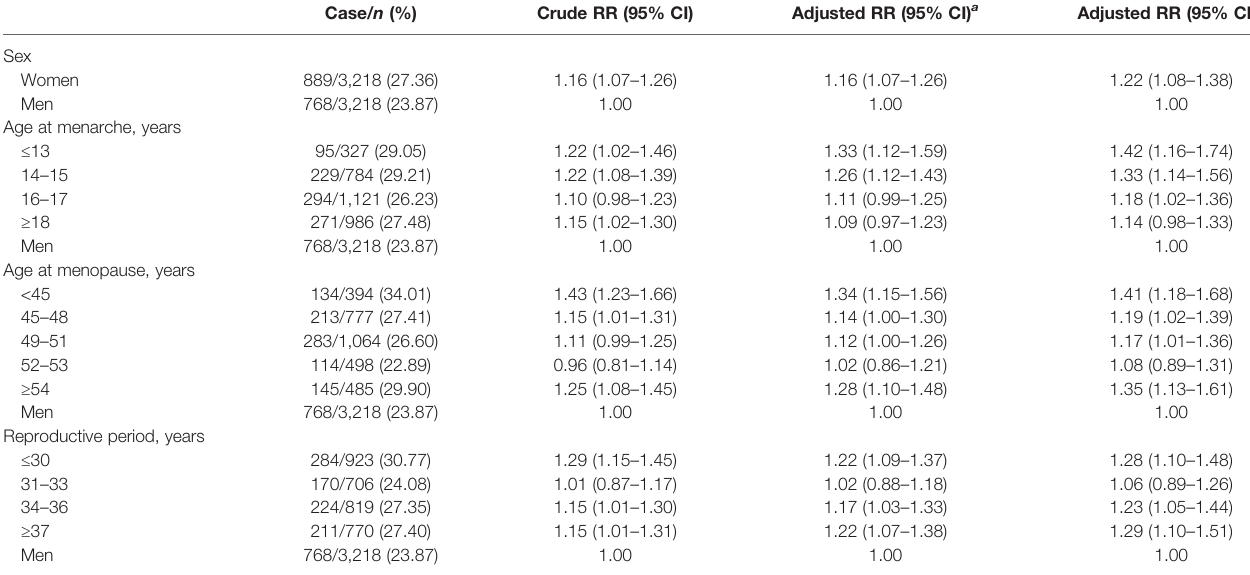
TABLE 2 | Association between sex, age at menarche, age at menopause, reproductive period, and objective memory impairment ( n =